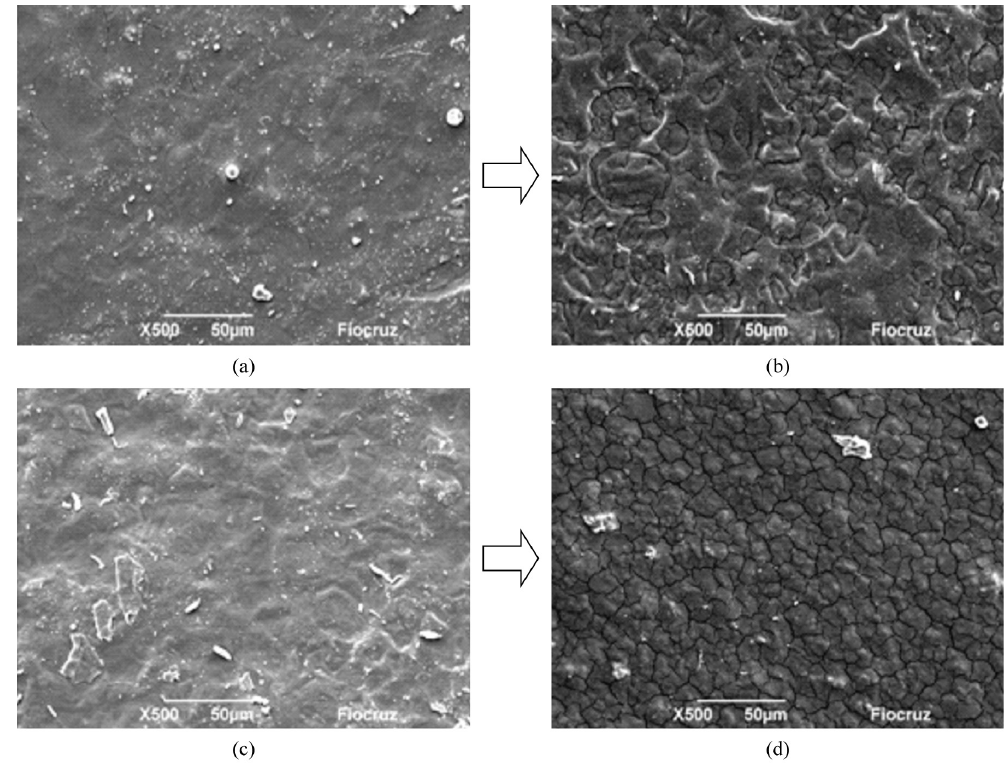
Figure 3. Scanning electron micrographs of the surface in 500x FSCA (a), FSCA2L (b), FSCO (c) and FSCO2L (d).